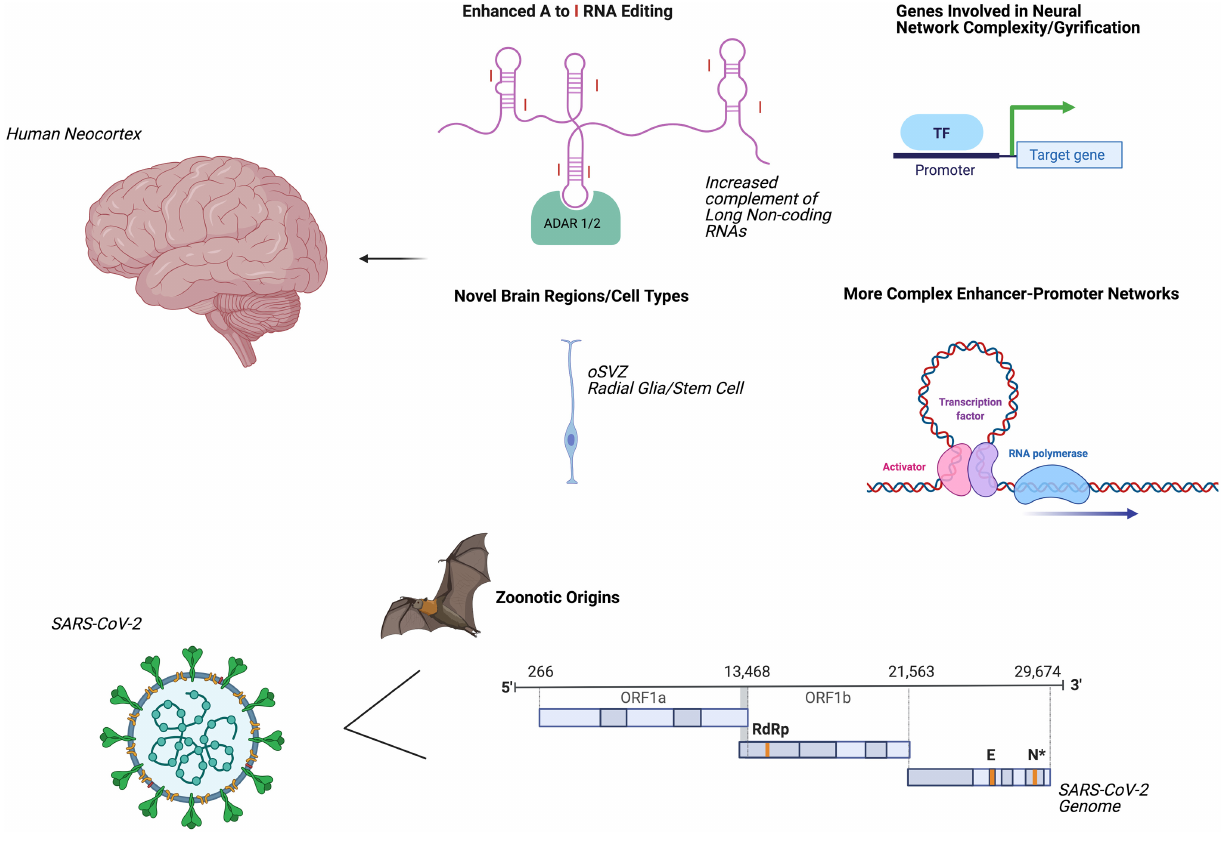
FIGURE 2 | Accelerated evolution of human brain and SARS-CoV-2: potential mechanisms underlying systemic dyshomeostasis. Evolutionary adaptations mediating innovations in human brain form and function (upper panel). Parallel evolutionary adaptations in SARS-CoV-2 (lower panel). Created using biorender.com. A, Adenosine; I, inosine; ADAR, adenosine deaminases acting on RNA; oSVZ, outer subventricular zone; TF, transcription factor; ORF, open reading frame; RdRp, RNA-dependent RNA-polymerase; E, envelope protein; N, nucleocapsid